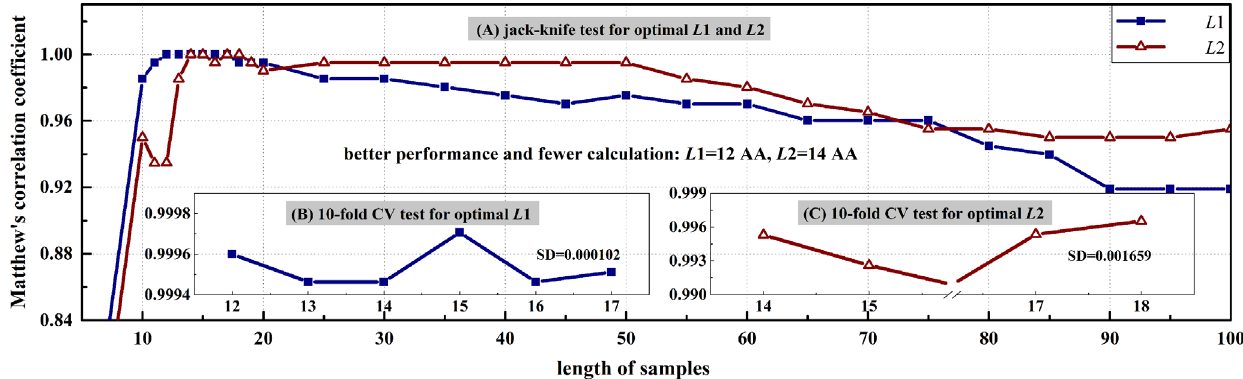
Fig 1. Change of average Mcc values versus different sample lengths. (A) Performance changes along with sample lengths from 10 AA to 100 AA under jack-knife test. (B)-(C) Performance varies along with optimal sample lengths selected in Fig 1(A) under 10-fold CV test. SD denotes the standard deviation of Mcc